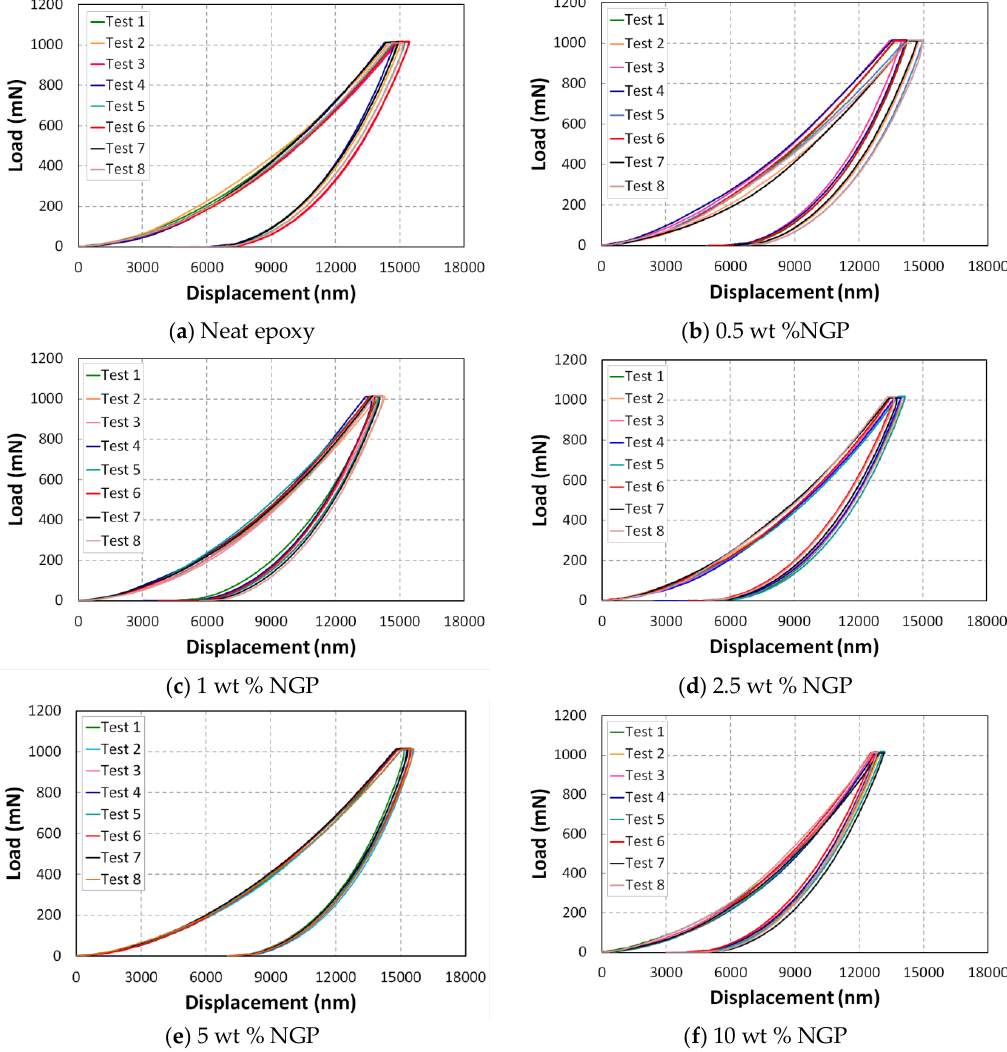
Figure 11. Indentation profile for epoxy matrix with graphene additives.